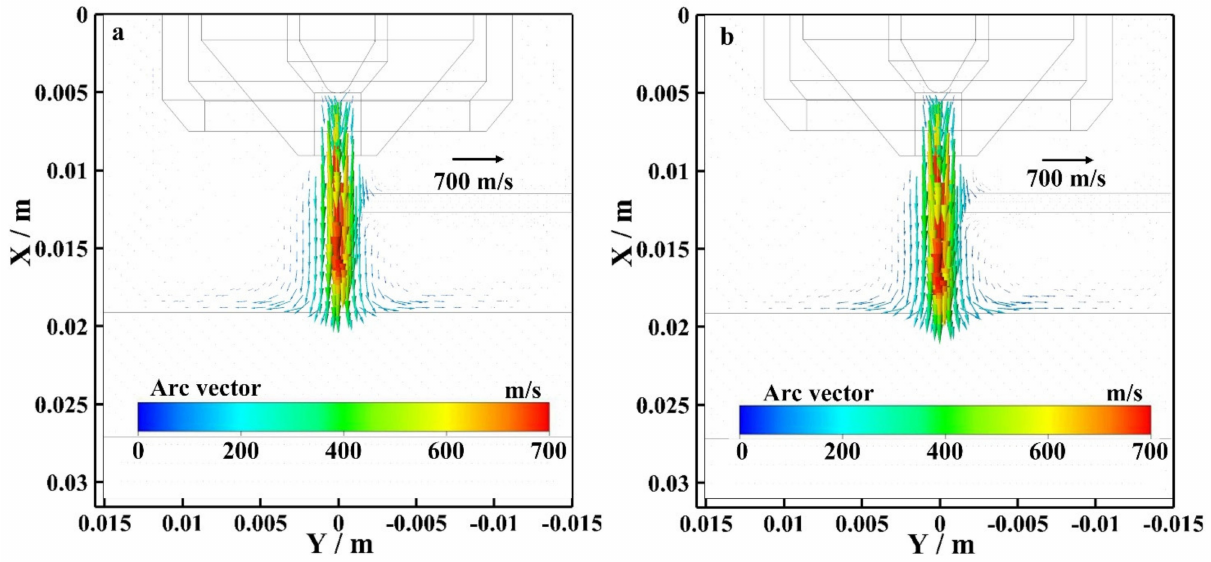
Figure 8. Flow field distribution of bypass coupling arc at EP phase with and without bypass current, ( a ) 120 A and 0 A, ( b ) 60 A and 60